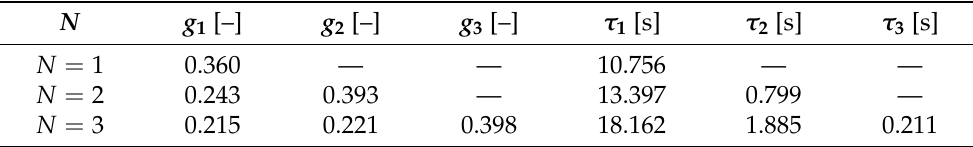
Figure 4. Fitting of the proposed viscoelastic model, for stage (1) of one of the specimens. Fits with N = 1, N = 2 and N = 3 terms in the Prony series are considered, with the corresponding parameters from Table 1. Table 1. Parameters g k , τ k of the viscoelastic model obtained for the specimen 635/21B for different values of k